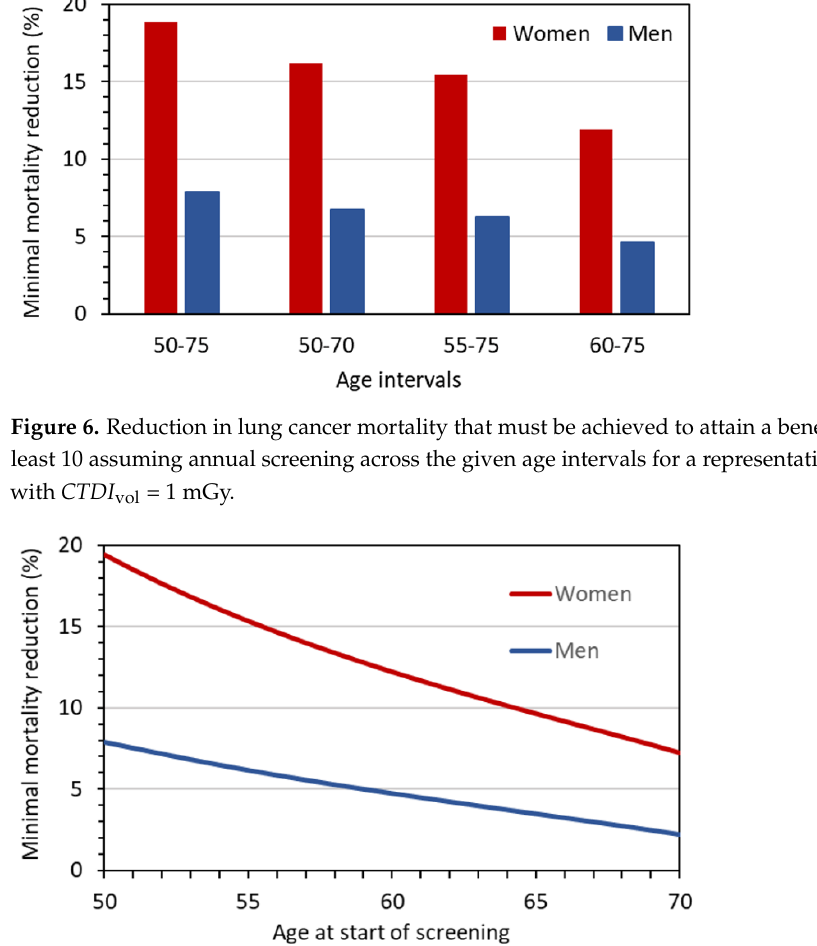
Figure 7. Reduction in lung cancer mortality that must be achieved to attain a benefit – risk ratio of at least 10 as a function of age at first screening examination assuming annual LDCT screening up to age 75 years for a representative LDCT protocol with CTDI vol = 1